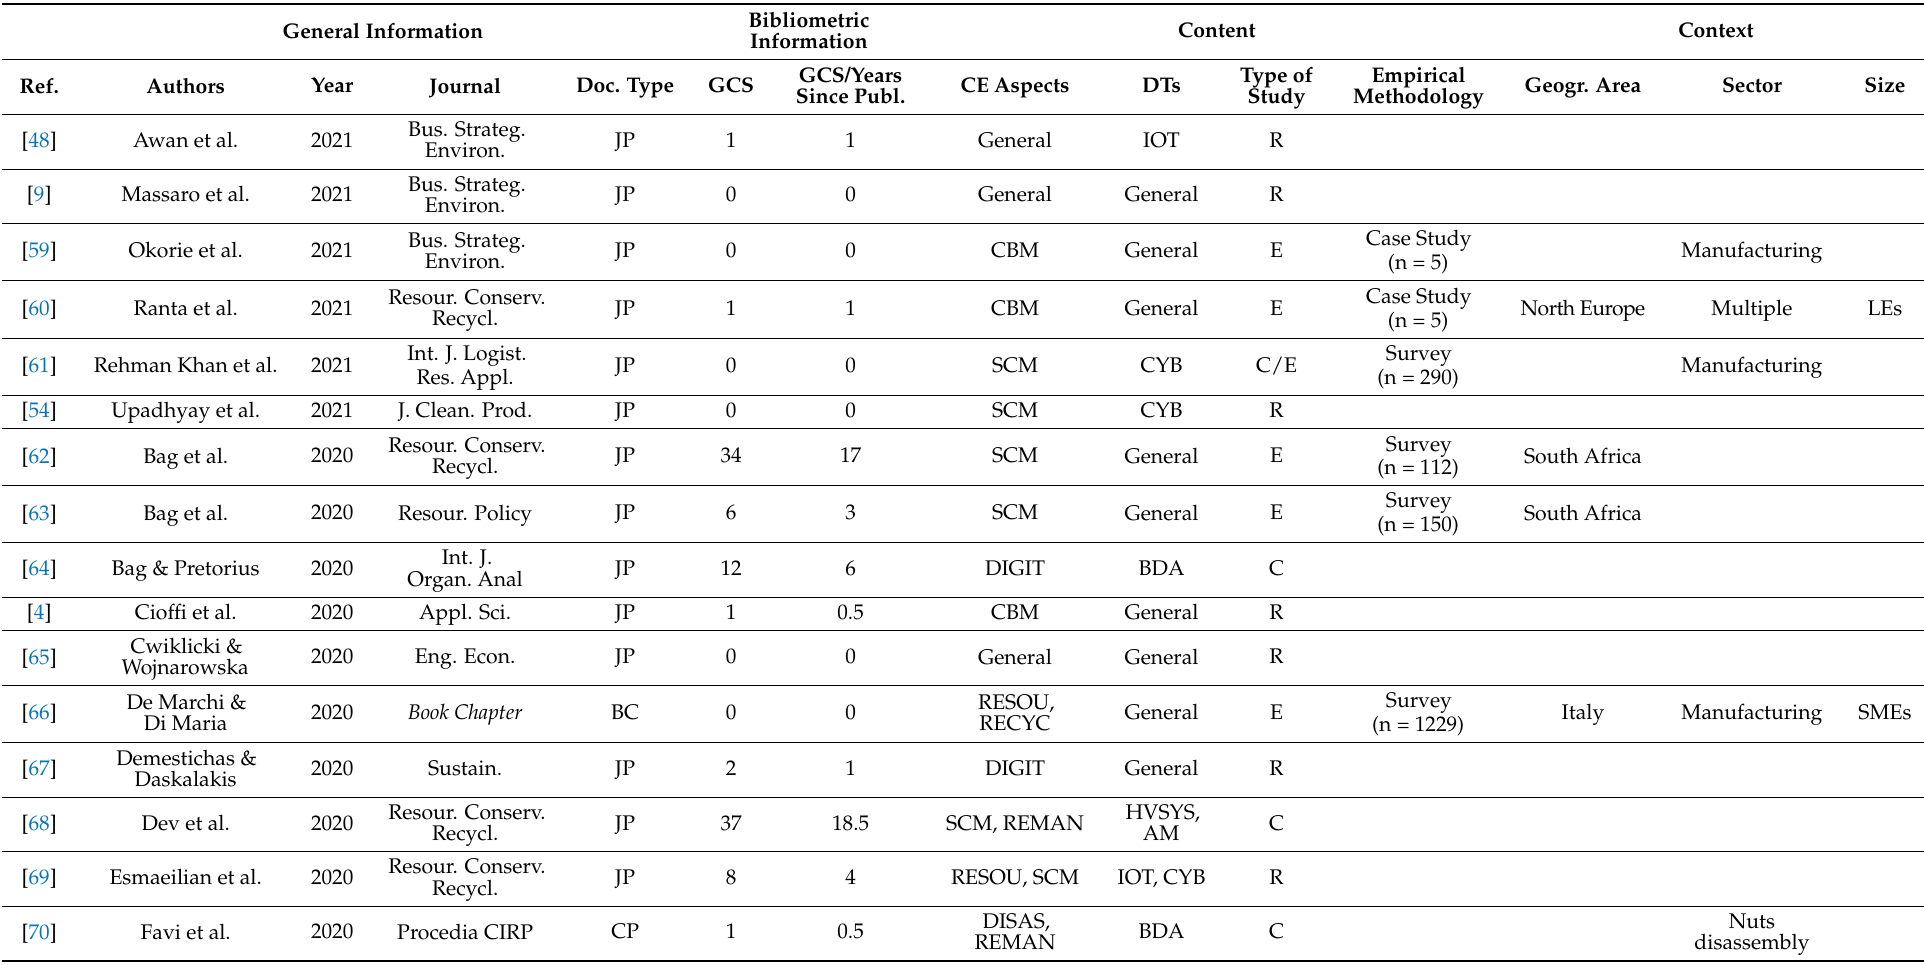
Table 2. Source evaluation. For the contributions considered for the review analysis, the table reports the following: general information: author, year of publication, journal, document type (JP: journal paper; CP: conference paper; BC: book chapter); bibliometric information: GCS, GCS/number of years since publication; content: CE aspects; DTs; type of study (R: review; C: conceptual; E: empirical); empirical methodology; context: geographical area, sector,